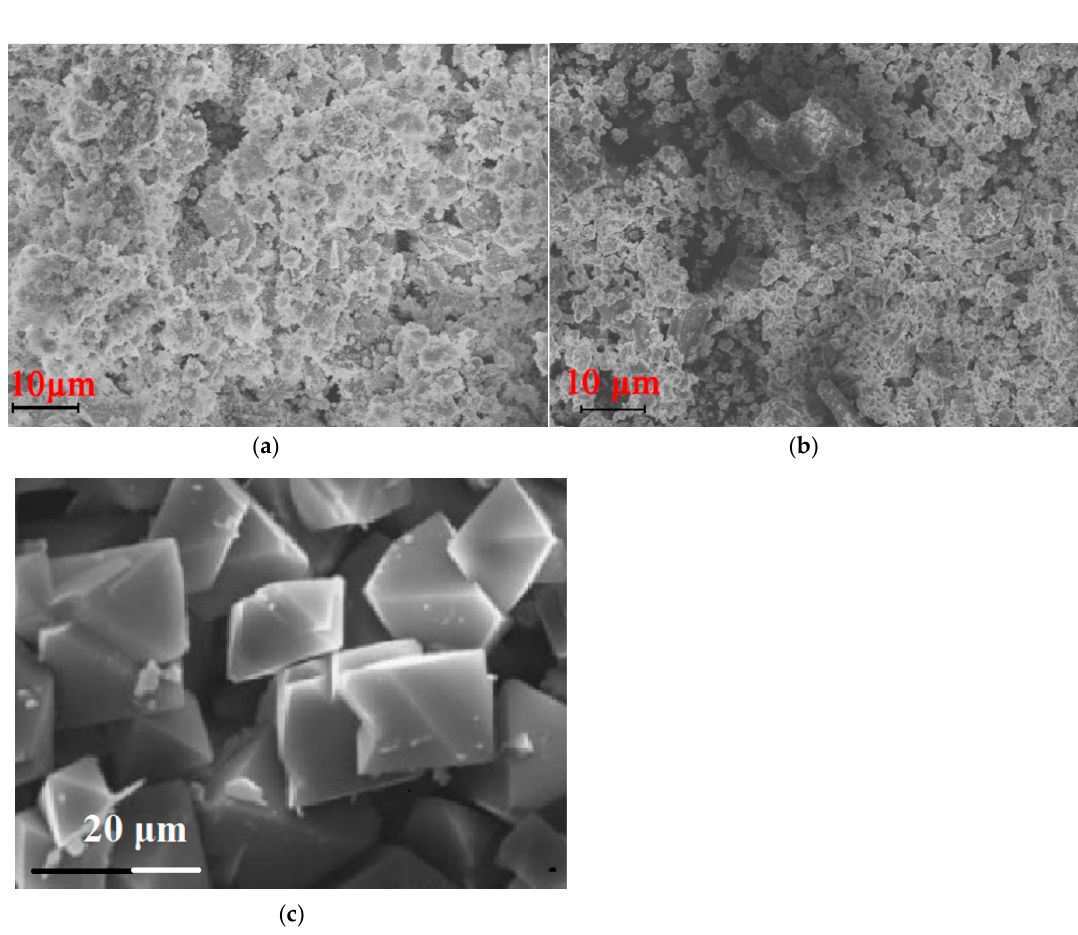
Figure 1. XRD pattern for copper trimesinate synthesized according to A (a), B (curve 1, b) and C (curve 2, b) methods